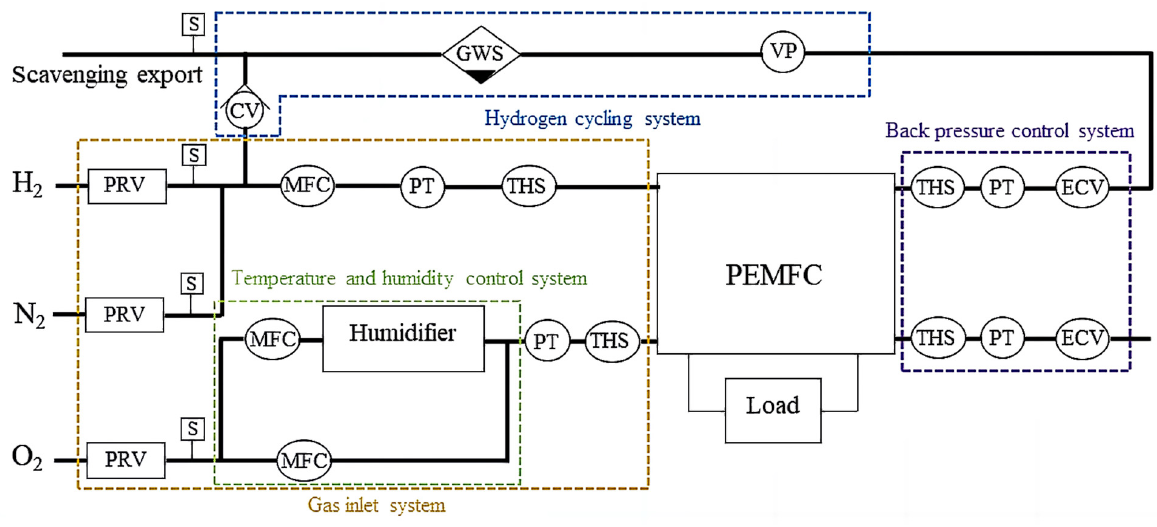
Figure 2. Schematic diagram of the gas control module.